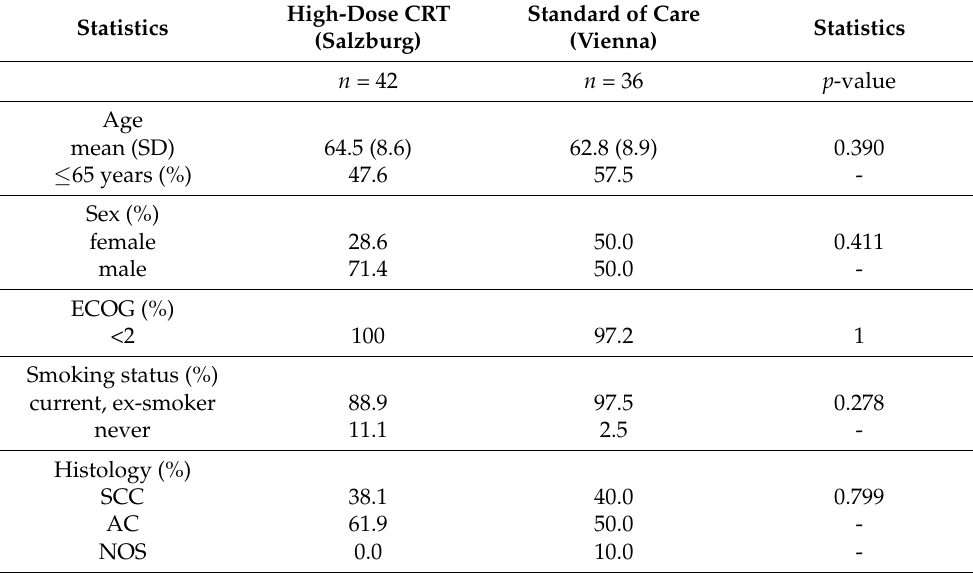
Table 1. Patient characteristics were equally distributed in both